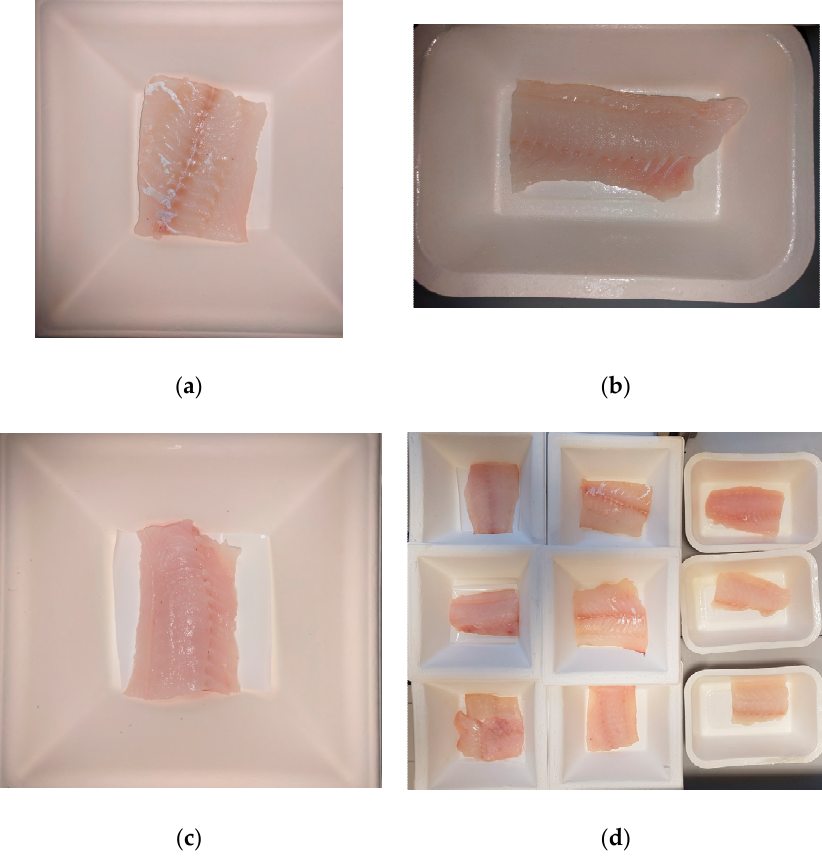
Figure 1. ( a ) The cod in the control box; ( b ) the cod in the box covered with a coating with polylysine; ( c ) the cod in the box covered with a coating with ZnO nanoparticles; and ( d ) the cod before welding.